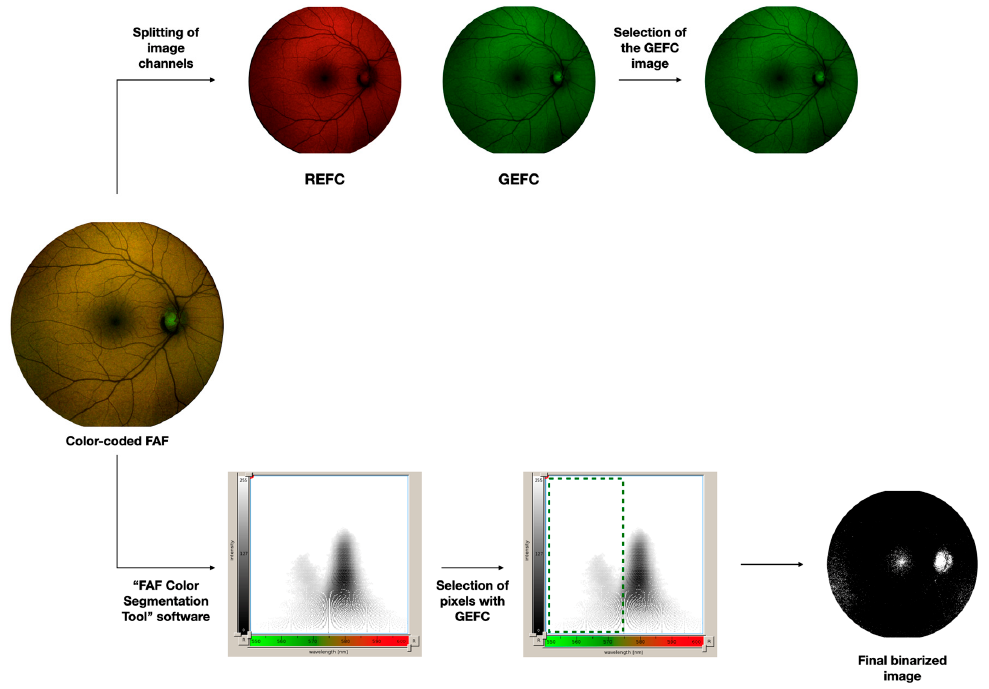
Figure 1. Representation of the algorithm used to process the